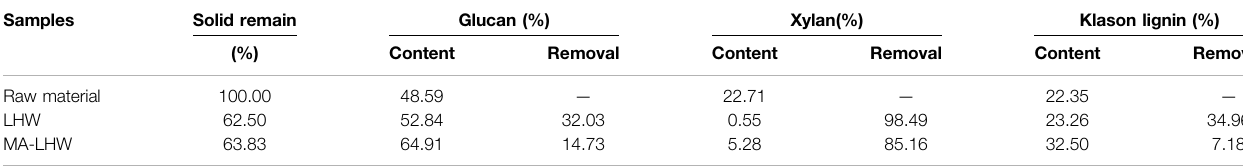
TABLE 1 | Chemical composition change after different pretreatments. Samples